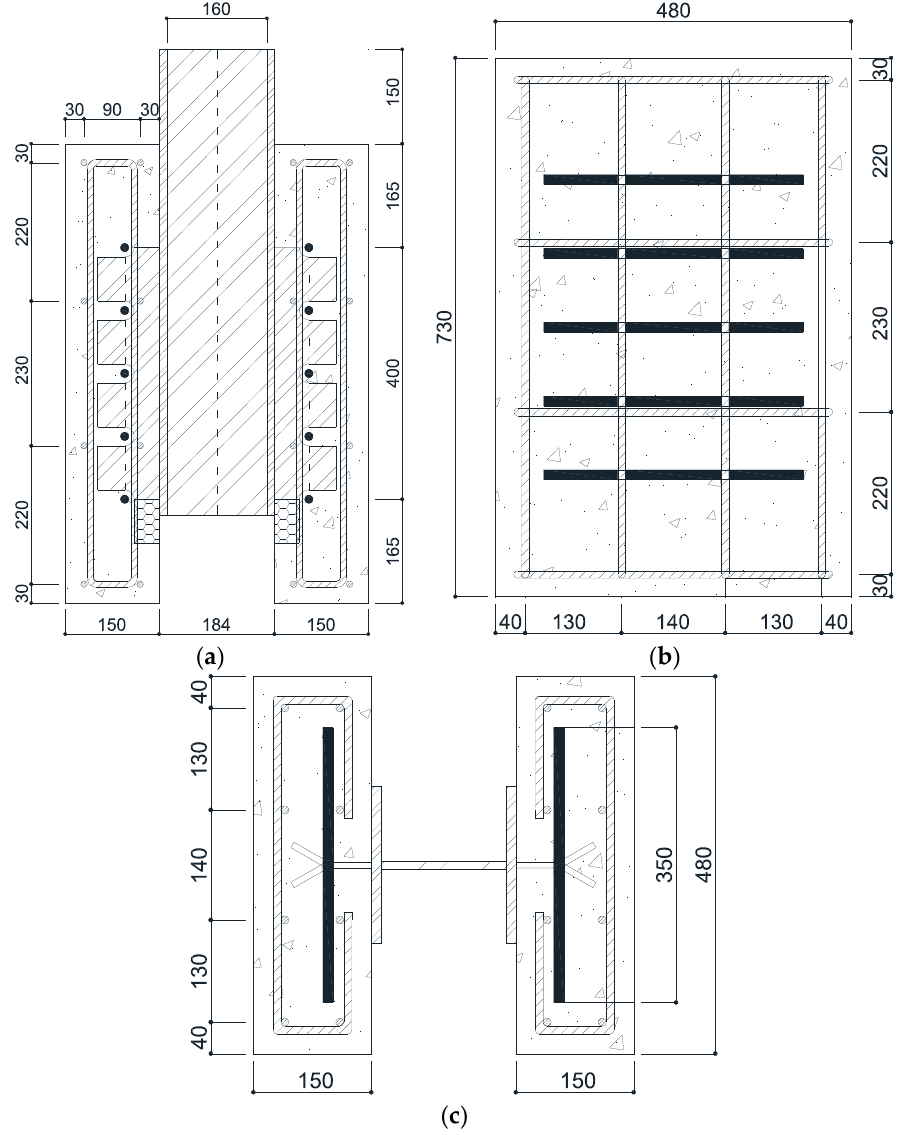
Figure 2. Dimensions of push-out test specimen (unit: mm). ( a ) Front view; ( b ) Side view; ( c ) Plan view. Table 1. Results of concrete compressive strength test.